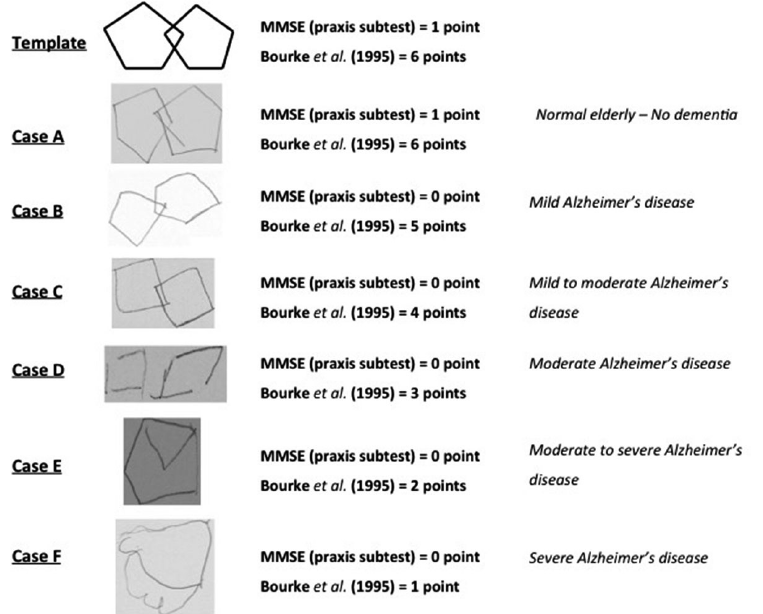
Figure 1. Template and clinical examples of the Pentagon Drawing Test in preserved older adults and Alzheimer’s